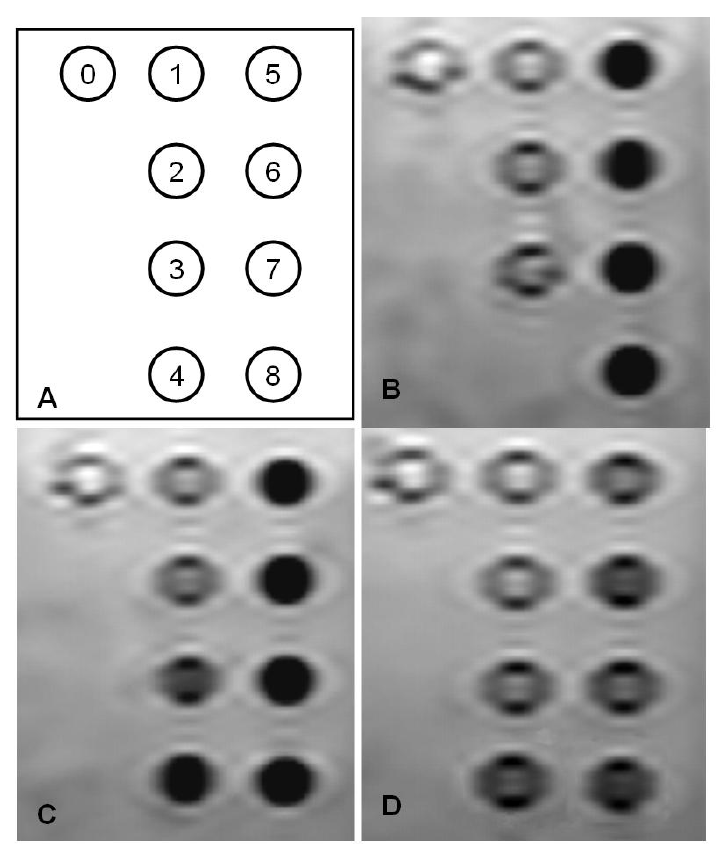
Figure 2. Spin echo MR image of the superparamagnetic iron oxide (SPIO) nanomaterials suspensions. (A) Diagram for iron concentration series; (B) SPIO@SiO